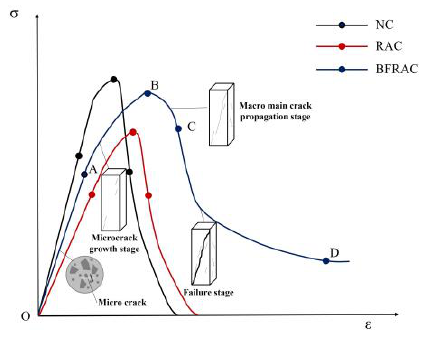
Figure 16. Whole process of BFRC under compression.